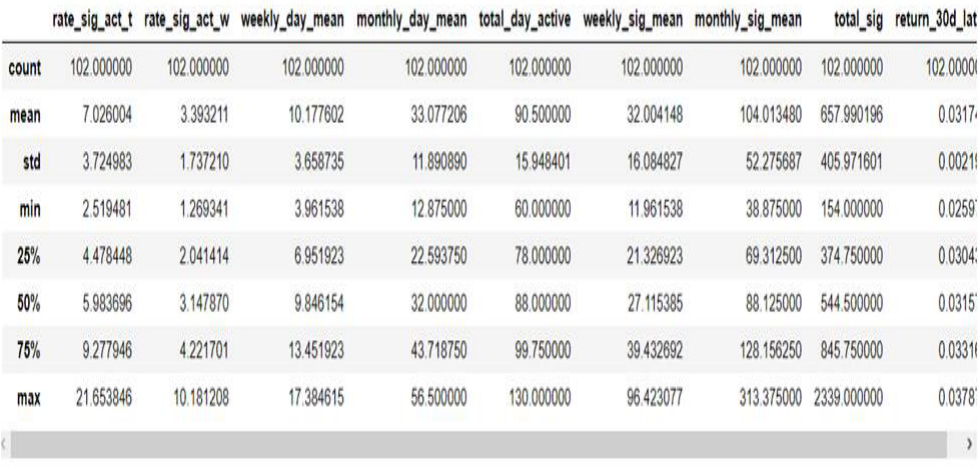
Figure 5. Factors statistics in cluster 1